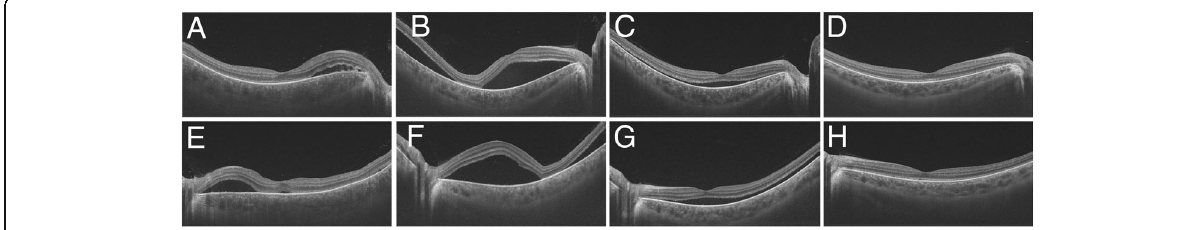
Fig. 3 High-penetrating swept-source optical coherence tomography findings during the follow-up. a – d Right eye. e – h Left eye. a , e Baseline. b , f One week after the therapy. c , g One month after the therapy. d , h Three months after the therapy. High-penetrating swept-source optical coherence revealed that serous retinal detachments resolved accompanied with a decrease of the central choroidal thickness in both